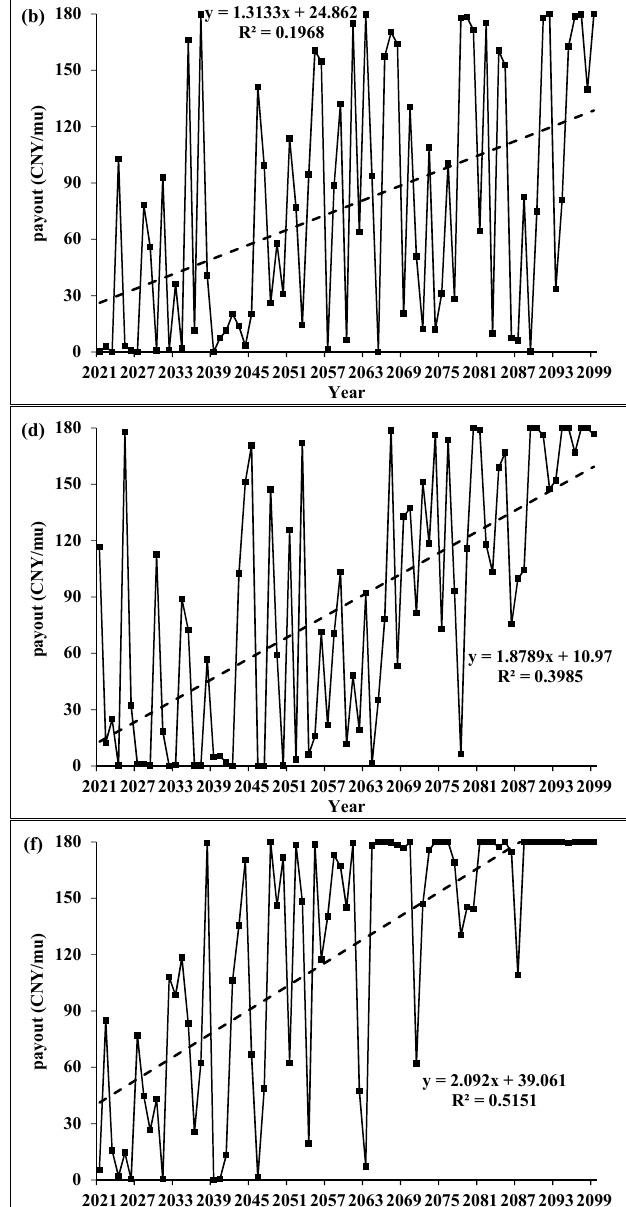
The greatest increase was 8.8 times in the far future under RCP8.5. There were minor dif- ferences between the HSWI under the three RCPs in the near future, while larger differ- ences were detected in the far future, and the HSWI under RCP8.5 was nearly 2 times higher than that under RCP4.5. The payout of the projected HSWI under the three RCPs ranged between 36.2 and 49.5 CNY mu − 1 , 66.9 and 128.5 CNY mu − 1 , and 100.5 and 167.3 CNY mu − 1 for the near fu- ture, mid-future and far future (Figure 7b), which are, on average, 3.9 times, 9.8 times and 15 times higher than the reference value. The greatest increase was 18.7 times in the far